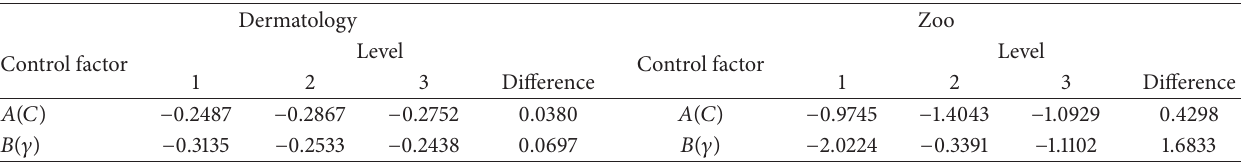
Table 8: Average of each factor at all levels.